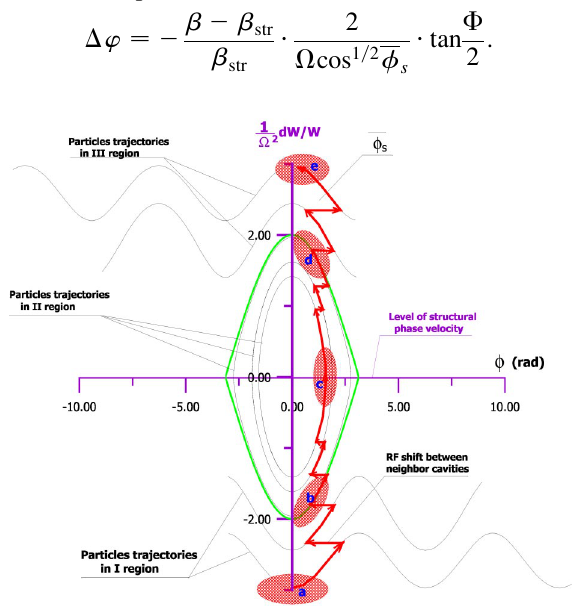
FIG. 3. (Color) Longitudinal motion in the stepped rf phase